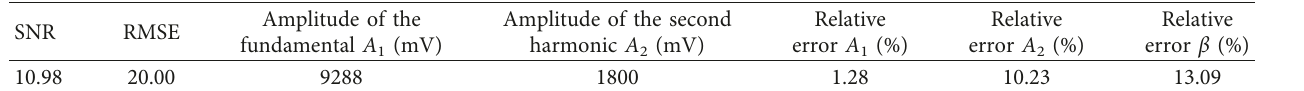
Figure 4: The SNR obtained by denoising with different wavelet bases and decomposition levels. Denoising by (a) Coif wavelet family, (b) Db wavelet family, and (c) Sym wavelet family. Table 2: Characteristic indicators of the signal after wavelet threshold